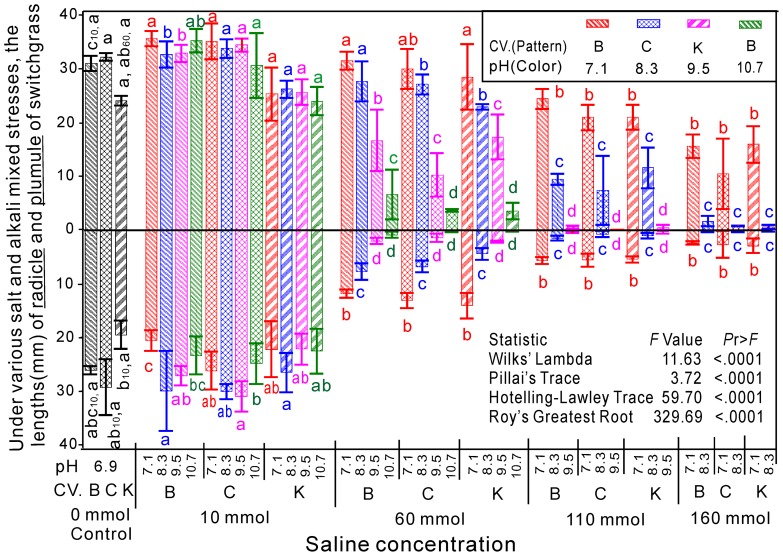
Effects of salinity and pH on the lengths of the plumules and radicles.Each saline concentration was separately compared with the control within the cultivar. The letters indicate the differences in the plumules or radicles within the groups. The letters indicate differences at P<0.05 within the groups. B, C and K correspond to the capitalized first letter of the switchgrass cultivars Blackwell, Cave-In-Rock and Kanlow.